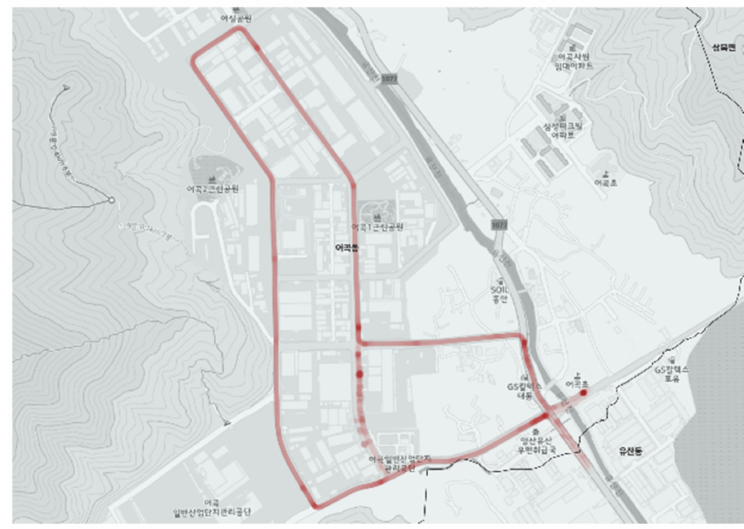
Figure 20. Actual driving record of city-type bus No. 5 (commuting).